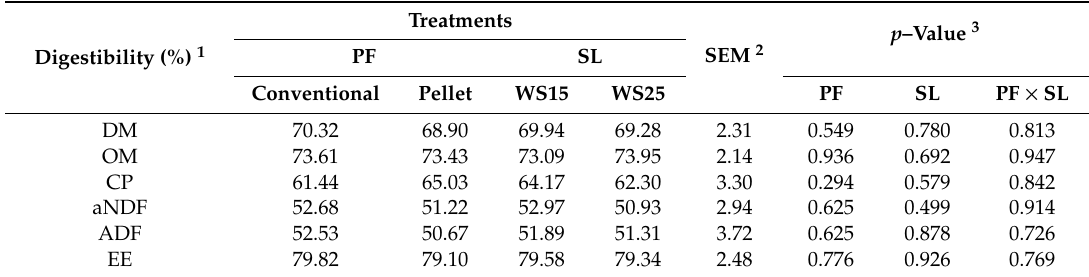
Table 5. E ff ects of conventional and pelleted TMR on nutrient digestibility coe ffi cients in fattening goats.